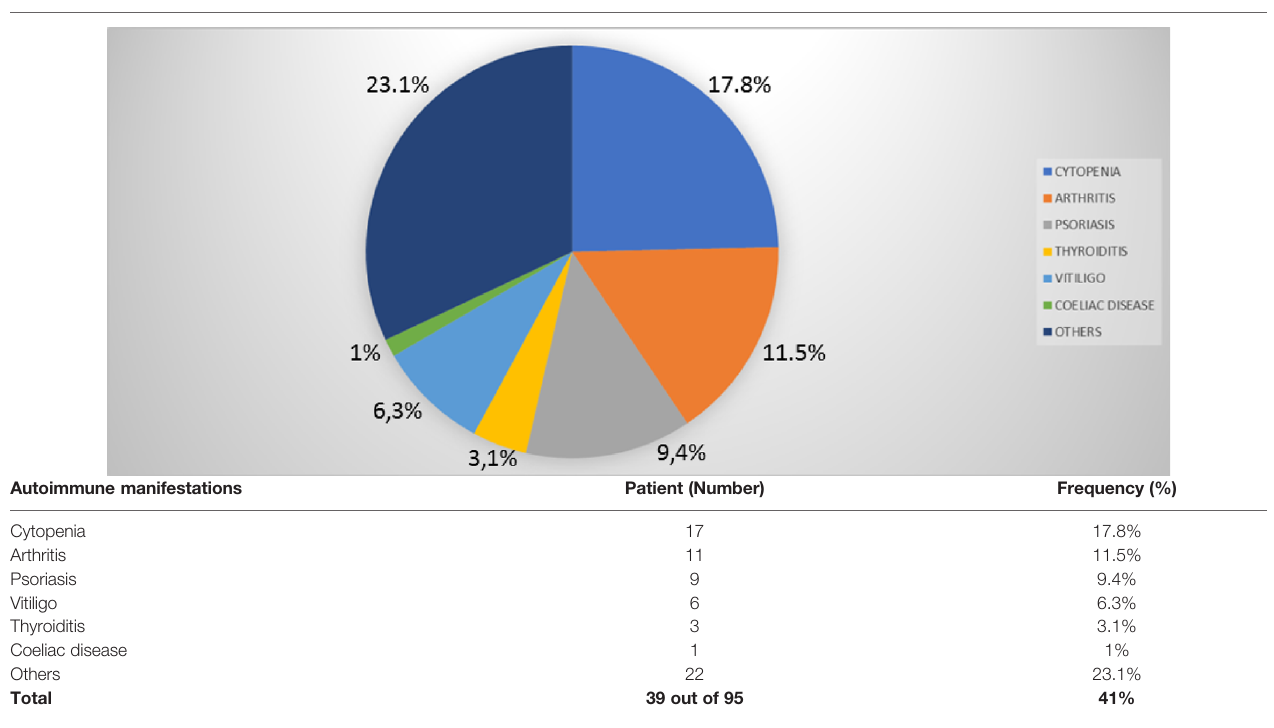
TABLE 1 | Distribution of autoimmune disease in 95 CVID